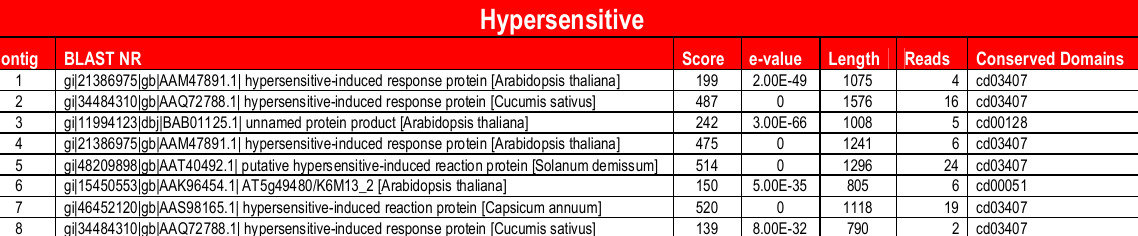
Table S3: EST-Contigs with e-value < e -20 and score > 100 obtained in the Project Hypersensitive, and their blast hit, score, e-value, size, number of reads, and conserved domains from putative proteins